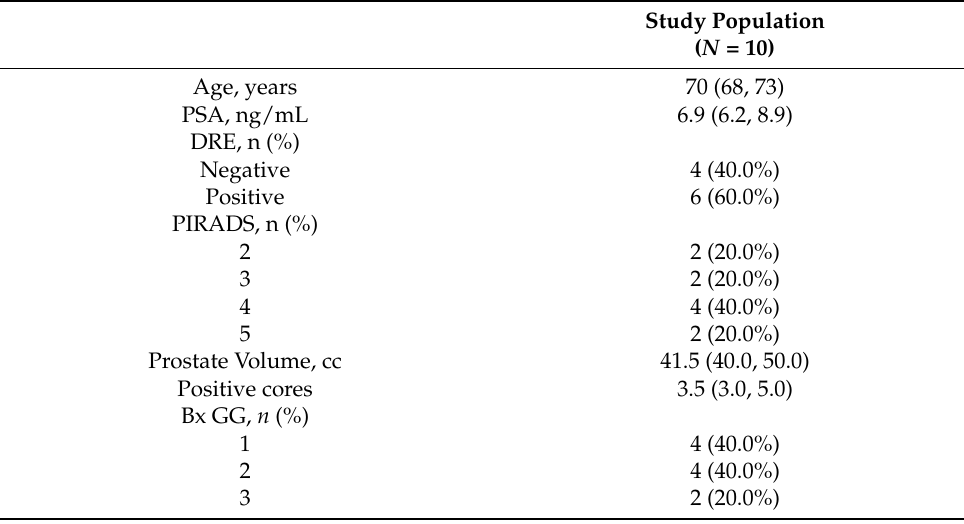
Table 1. Descriptive characteristics of the study